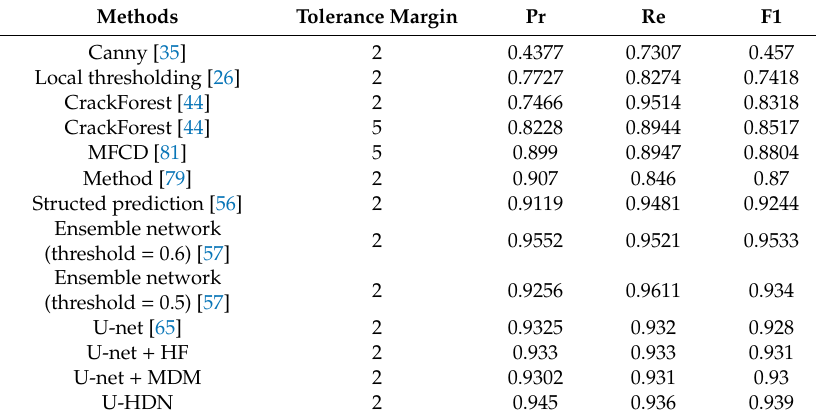
Table 4. Crack detection results on CFD.